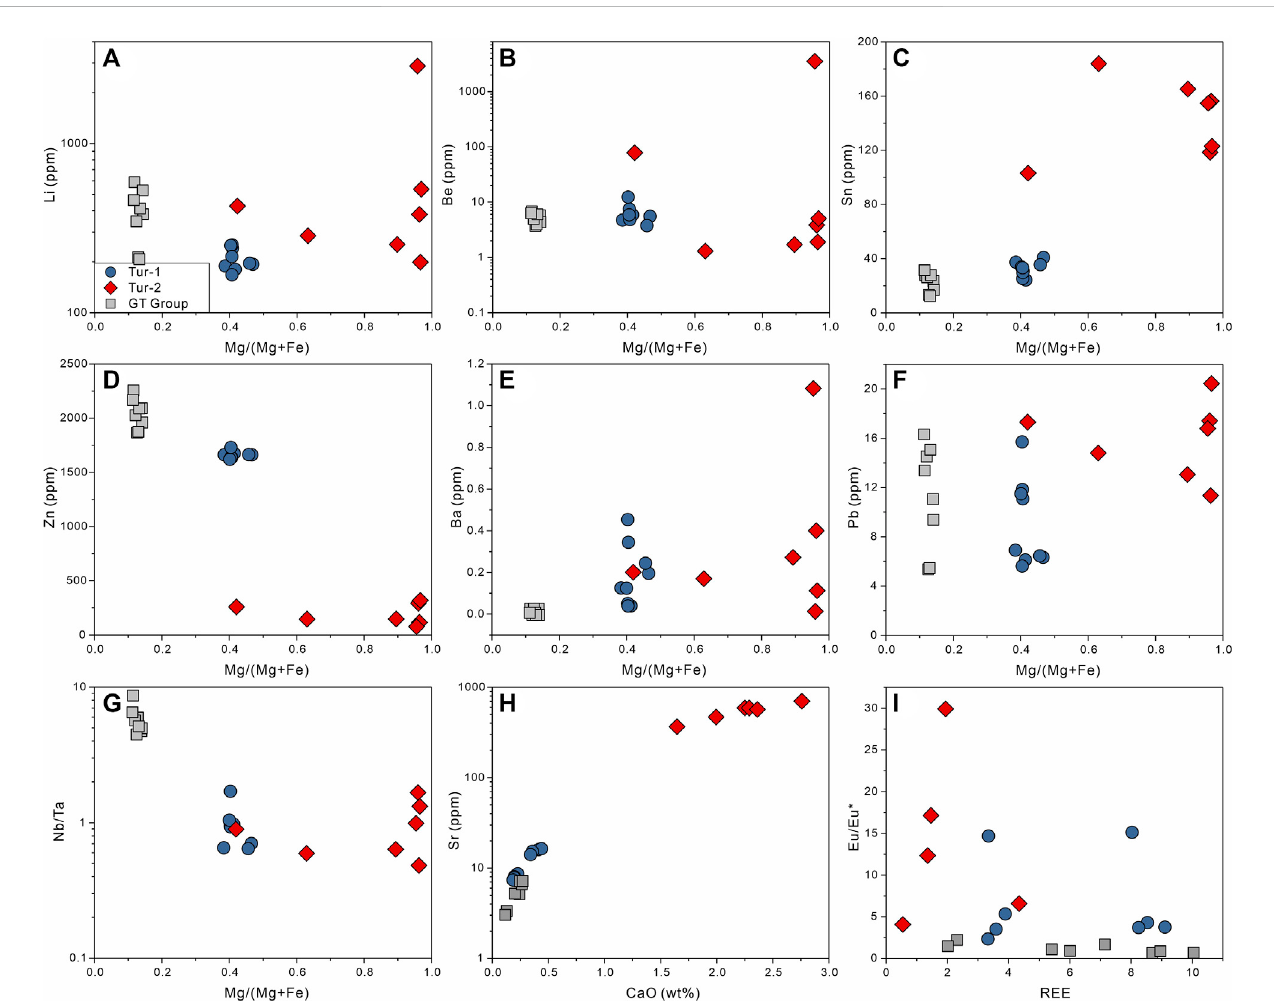
FIGURE 6 Correlation diagrams between trace elements or ratios and Mg/(Mg + Fe) in the tourmaline from the Cuonadong leucogranite (GT group, gray square), hydrothermal quartz vein (Tur-1, blue circle), and skarn (Tur-2, red rhombus) in the Cuonadong Sn – W – Be polymetallic deposit. (A) Li vs. Mg/(Mg + Fe); (B) Be vs.Mg/(Mg+Fe); (C) Snvs.Mg/(Mg+Fe); (D) Znvs.Mg/(Mg+Fe); (E) BavsMg/(Mg+Fe); (F) Pbvs.Mg/(Mg+Fe); (G) Nb/Tavs.Mg/(Mg+Fe); (H) Srvs.CaO; (I) Eu/Eu* vs REE. The data on the tourmaline from the Cuonadong leucogranite in the Xianglin area (GT group, gray square) are obtained from Xie et al.